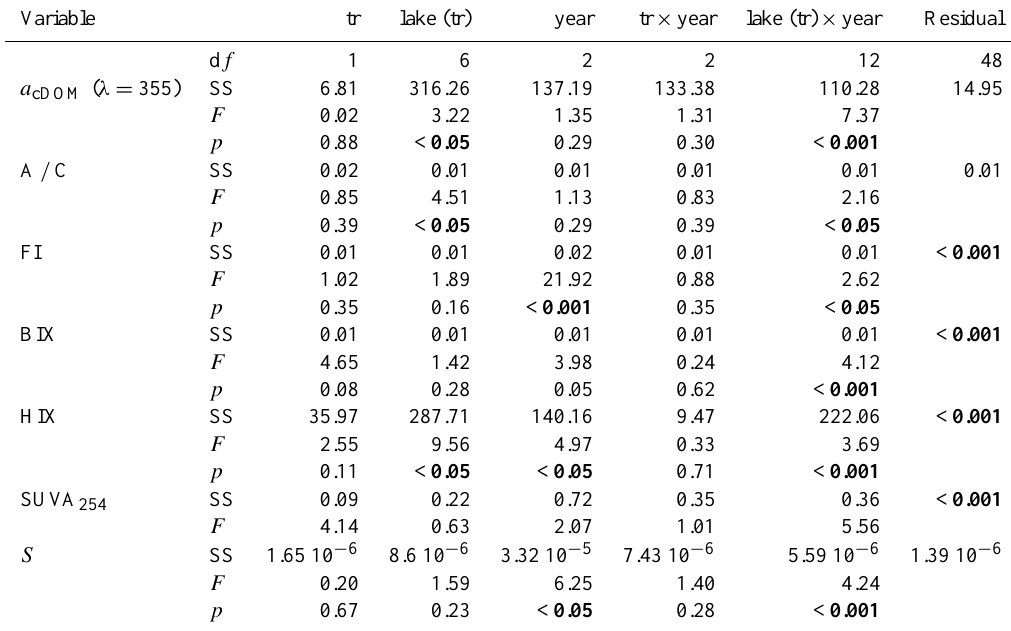
Table 4. Results of the three-way ANOVA testing the effect of treatment (tr: perturbed, unperturbed), lake, year and their interactions on absorbance coefficients of CDOM ( a cDOM ) at 355nm, A / C peak ratios, fluorescence index (FI), biological/autochthonous index (BIX), humification index (HIX), specific UV absorbance at 254nm (SUVA 254 ) and spectral slope ( S ). The principal source of variation of interest is the interaction between the treatment and the year of sampling. Significant p values ( p < 0 . 05) are in